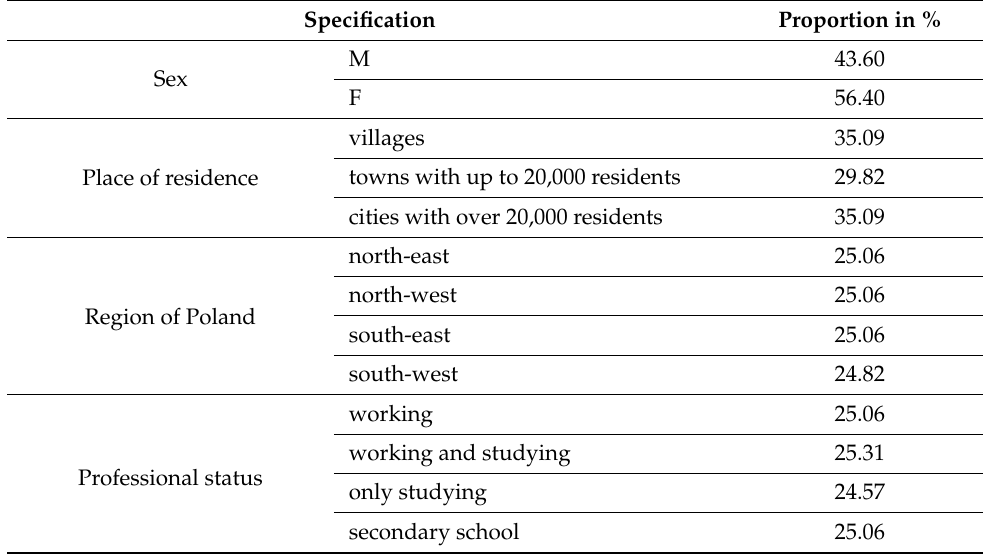
Table 1. General characteristics of the study population.